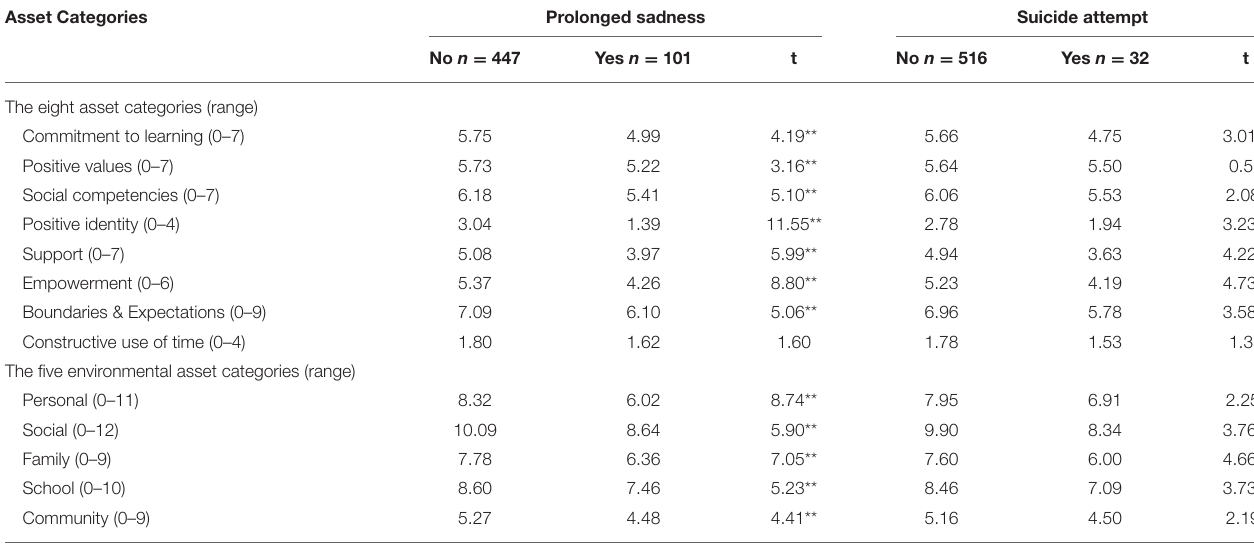
TABLE 3 | Poor mental health indicators by mean number of assets experienced: t –test analysis. Asset Categories